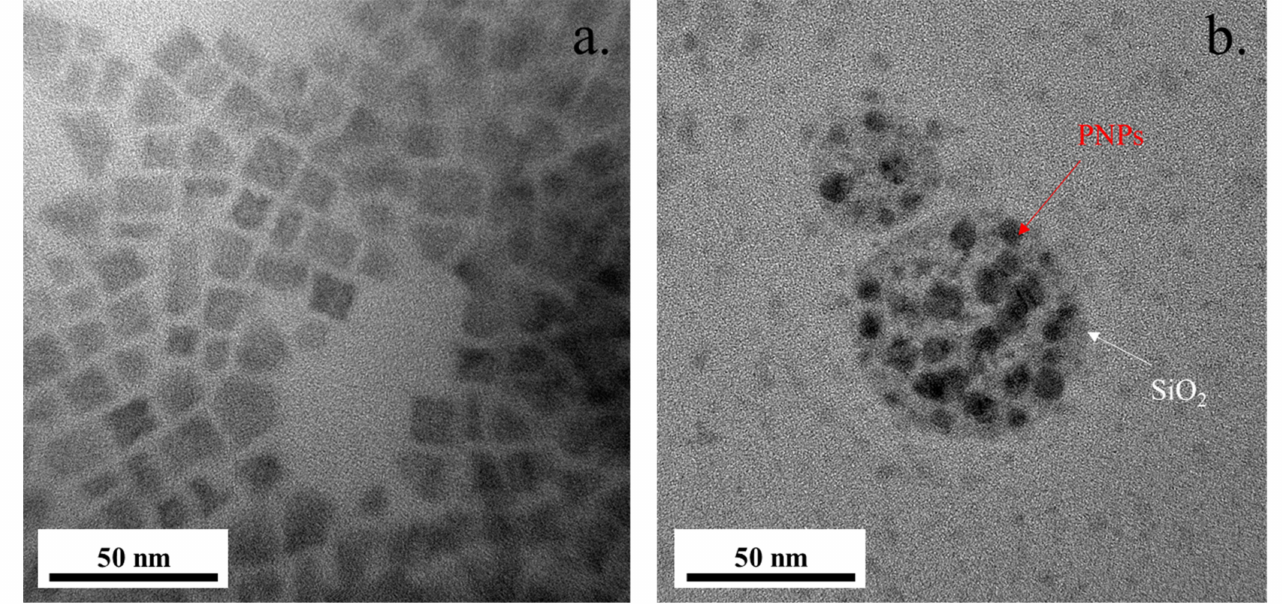
Figure 3. HRTEM images of ( a ) PNPs and ( b )